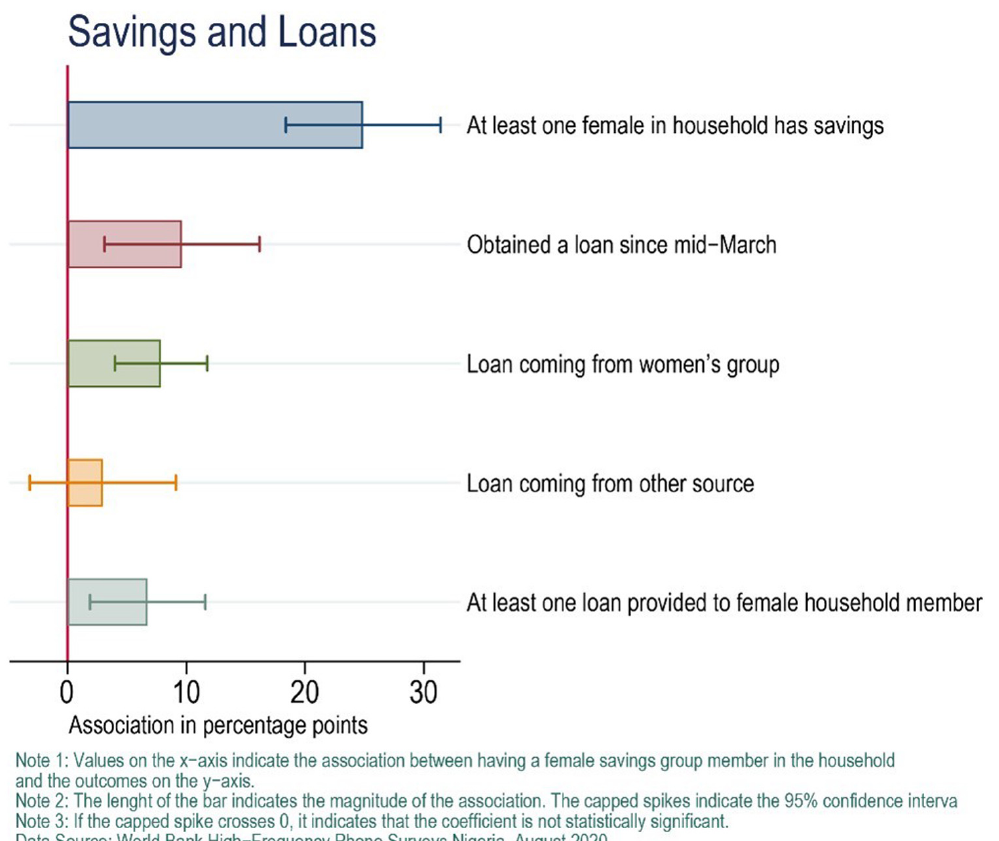
Figure 1. Access to savings and credit in Nigeria after